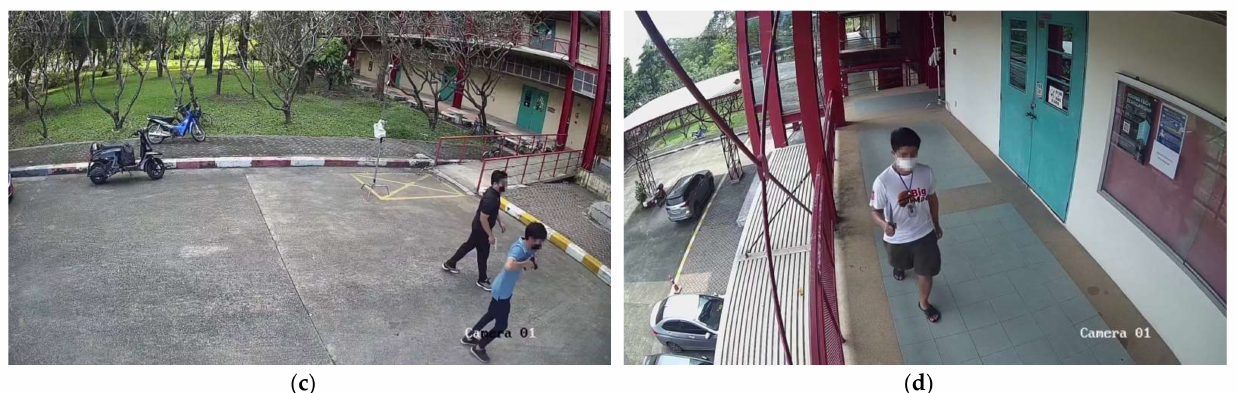
Figure 6. Example of location in the data collection process: ( a ) Parking lot 1, ( b ) Parking lot 2, ( c ) Parking lot 3, ( d ) Corridor.